Question: Is the quantity shown trending increasing or decreasing?
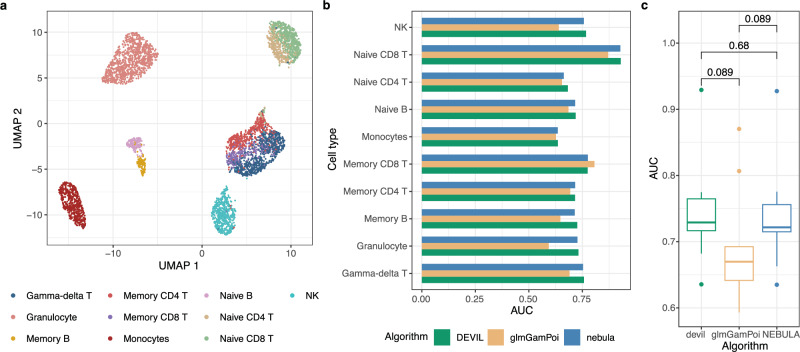
Answer: increasing